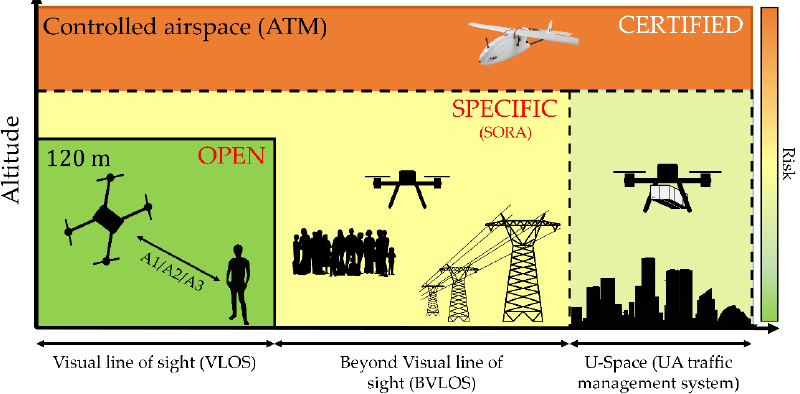
Figure 3. Scheme of UAS regulation in terms of altitude, distance from the pilot, and risk assessment. Both hobby and professional users can operate the drone in the open category by obtaining a pilot certificate. A brief scheme of rules of the open category is reported in Table 2. Of note, there is a relation between the MTOW (UAS requirements) and the subcategory limitations. Every UAS within 250 g and 4 kg can fly close to un-involved people and buildings, while the UAS over 4 kg has to be operated at a distance from people and buildings. Table 2. EASA pilot certificate’s category, limitations, and UAS requirements. Cat.